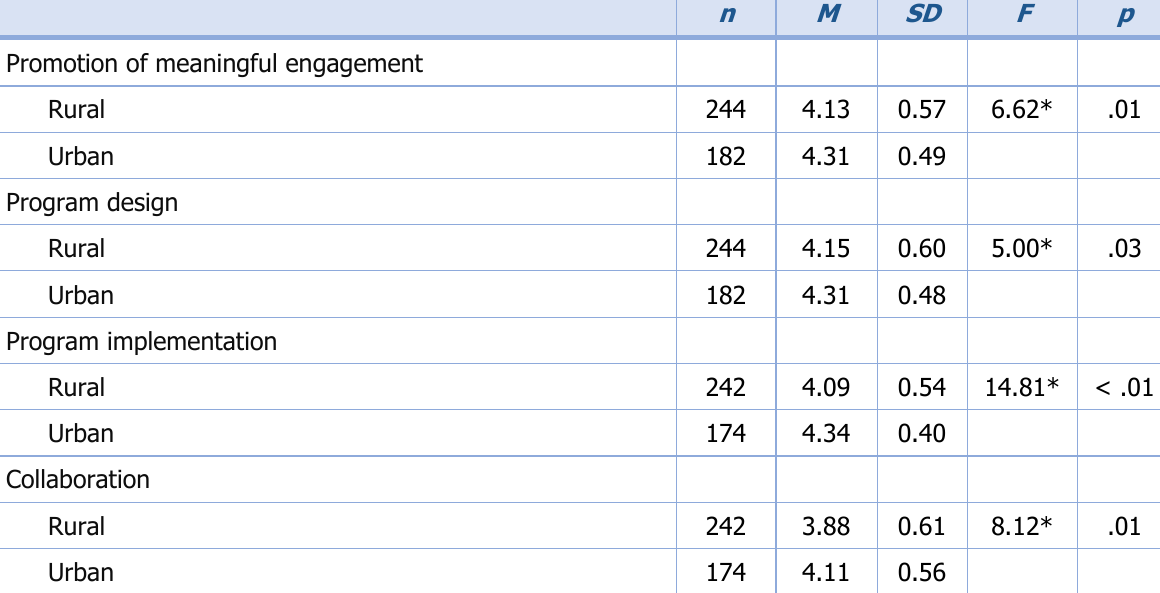
Table 8. Differences Between 4- H Extension Agents’ Perceived Importance of the AEO Domain’s Inclusive Programs Components and the Rural/Urban Characteristic